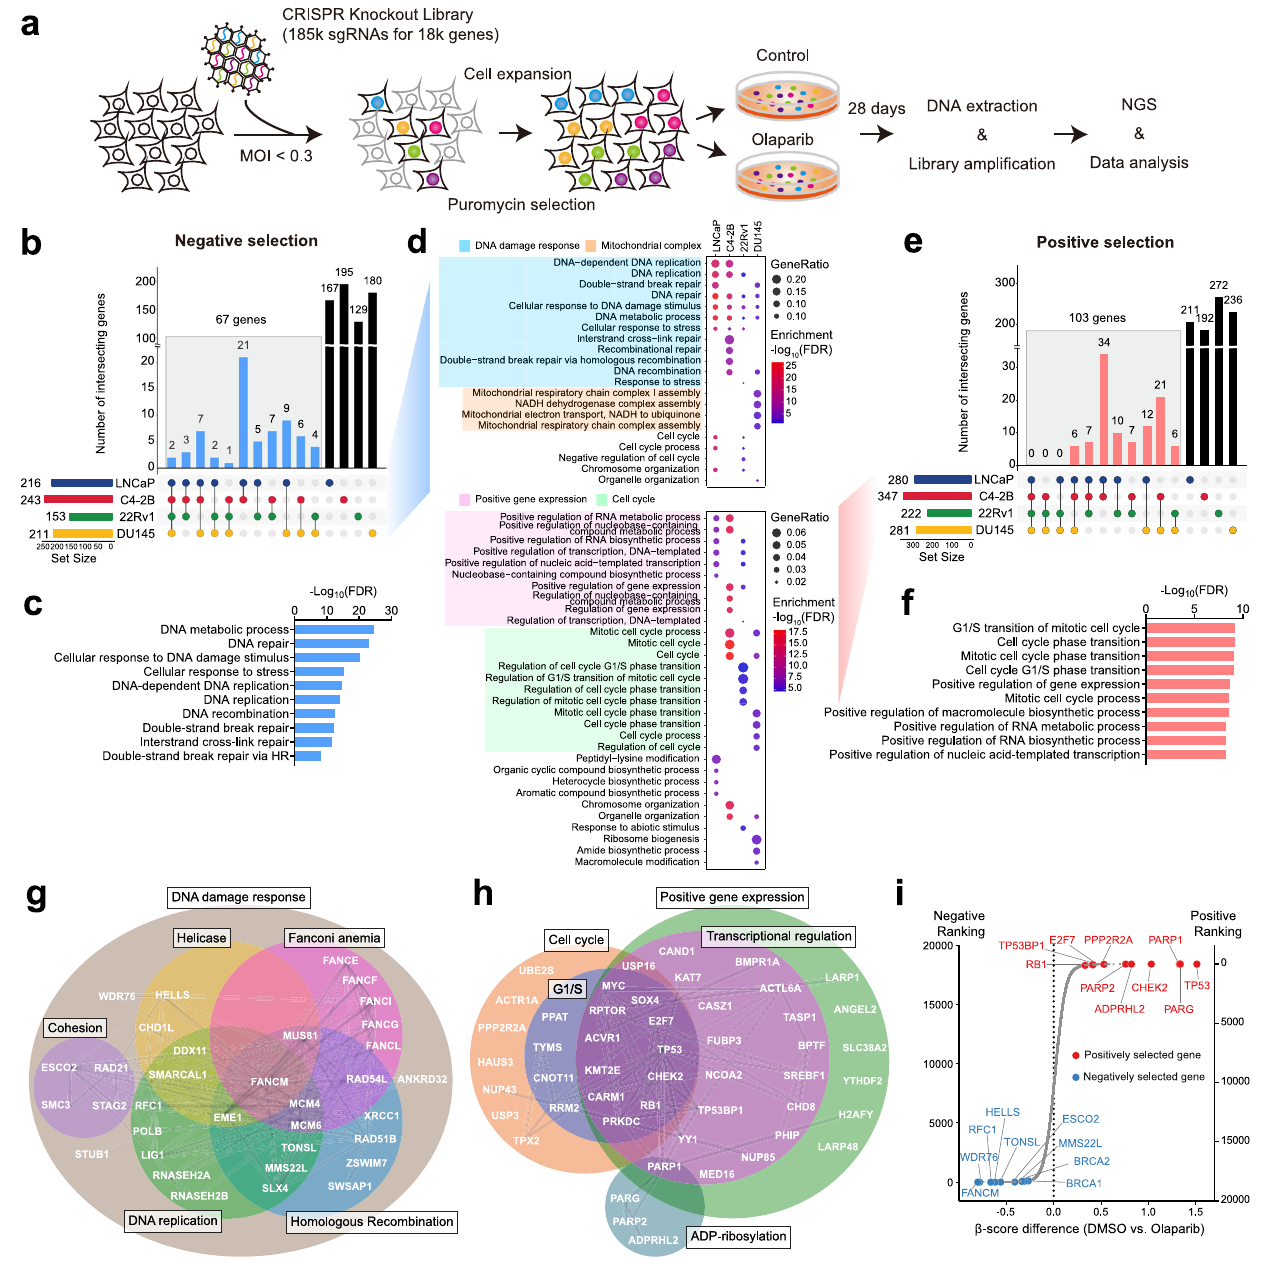
Fig. 1 | CRISPR screens identify genes that modulate PARPi response in PCa cells. a Schematic of genome-wide CRISPR/Cas9 screens. b UpSet plot 110 of nega- tively selected genes in four PCa cell lines as indicated. Blue bars indicate the number of common hits in at least two screens. c Top GO terms enriched in 67 common hits from negative selection. d Top GO terms enriched in negatively (upper panel) and positively (lower panel) selected genes in each individual cell line. e UpSetplotofpositivelyselectedgenesinfourPCacelllinesasindicated.Red bars indicate the number of common hits in at least two screens. f Top GO terms